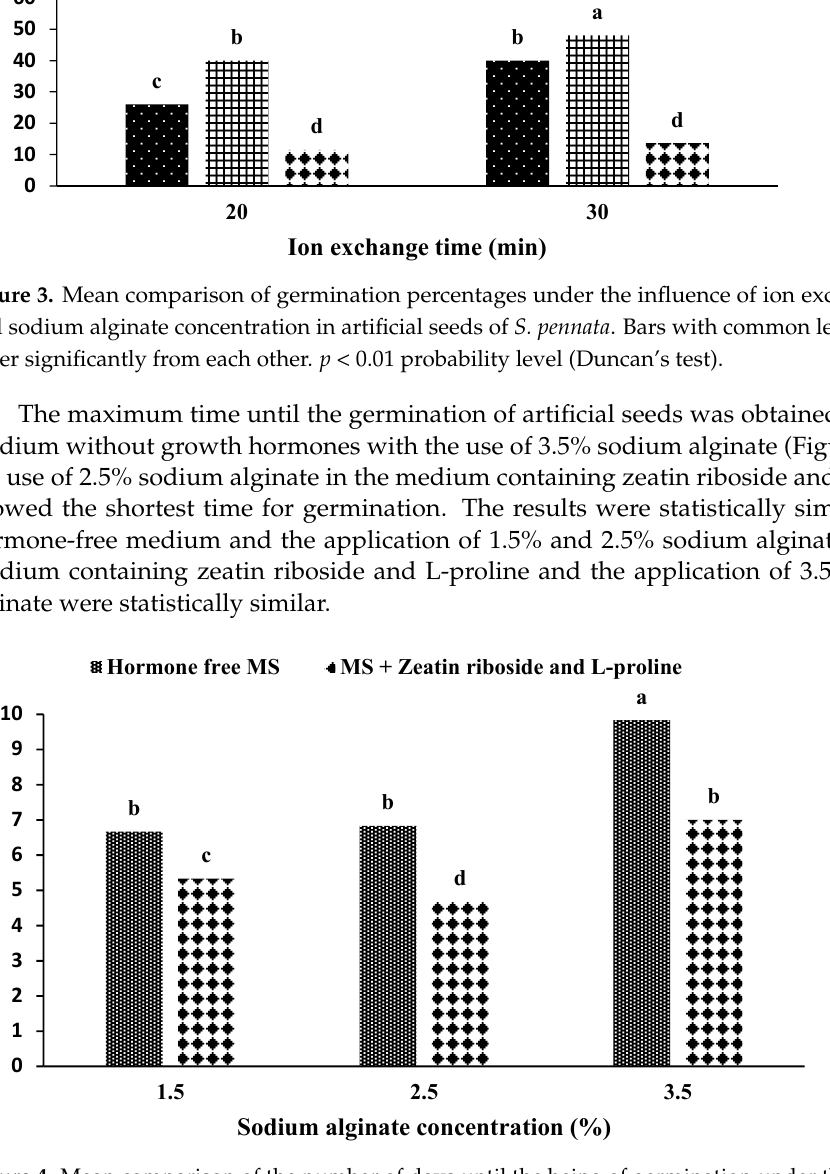
Figure 4. Mean comparison of the number of days until the being of germination under the influence of the germination medium and sodium alginate concentration in artificial seeds of S. pennata . Bars with a common letter do not differ significantly from each other. p < 0.01 probability level (Duncan’s test). MS—Murashige and Skoog